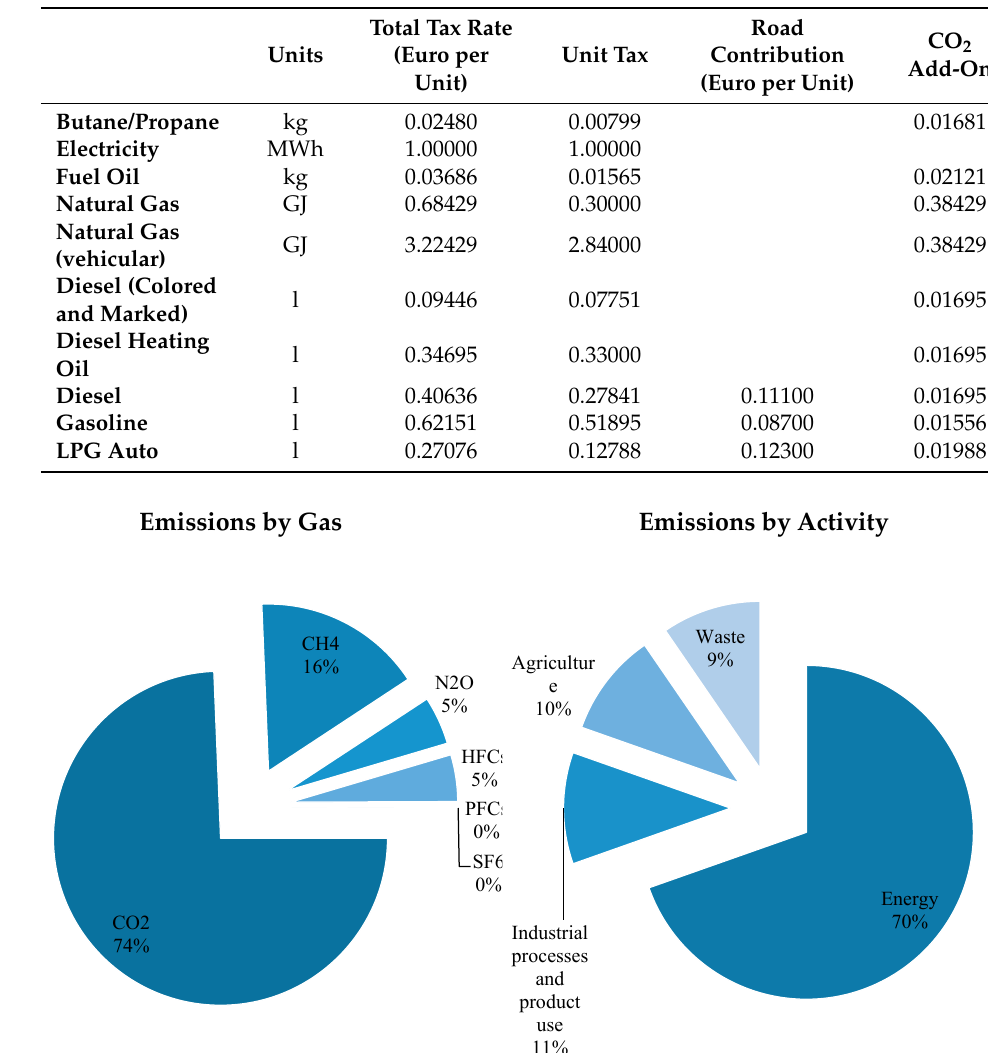
Figure 4. Air pollutant emissions. We model emissions of the different GHG and air pollutants in two different ways. For emissions that are generated by fossil fuel combustion, i.e., the co-pollutants with car- bon dioxide, we model emissions as a direct function of the amount of the fossil fuel used in the corresponding activities. For emissions that are induced by agriculture and indus- trial processes, we modeled them as a fixed function of the output of each of the different production sectors or activities.